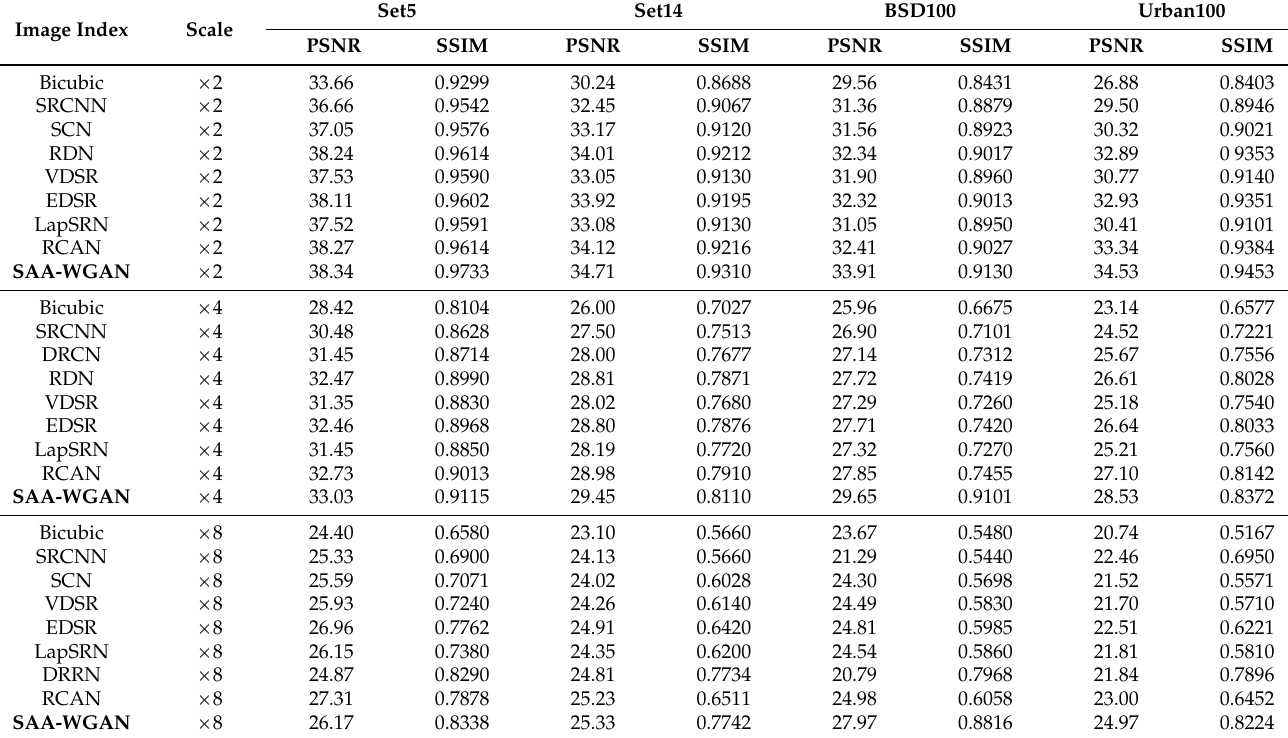
Table 2. SR results of